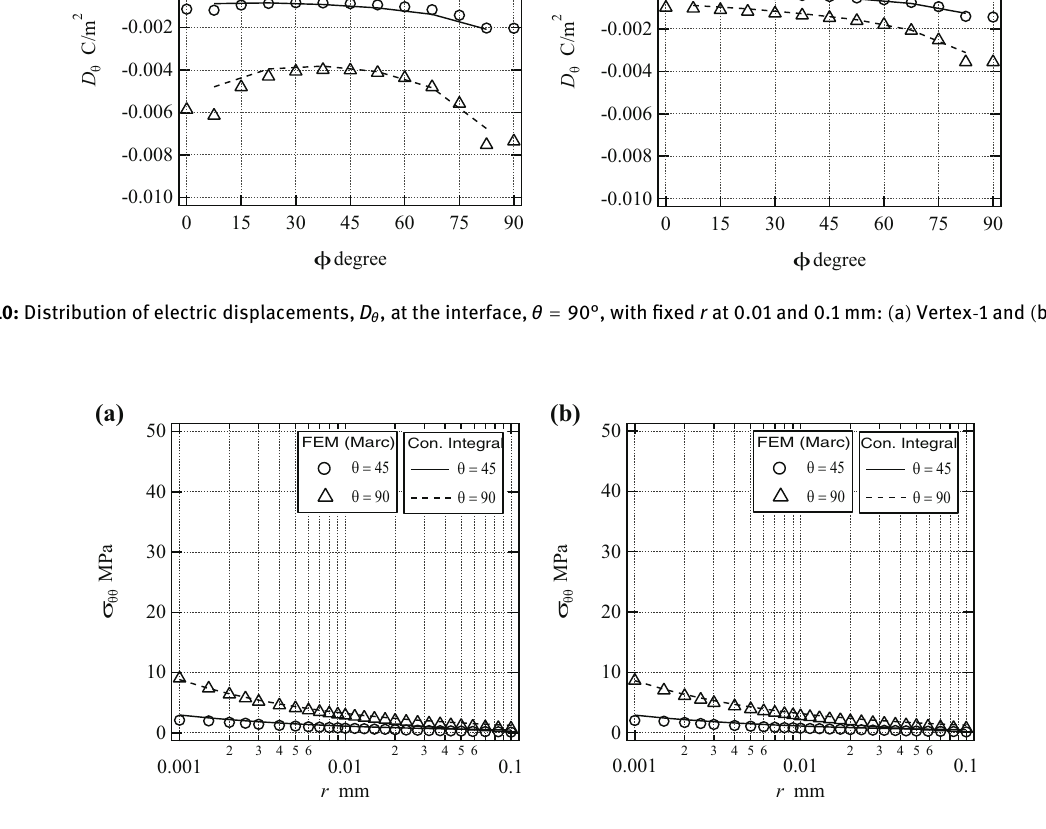
Figure 11: Distribution of normal stresses, σ θθ , at ϕ = 90° and θ = 45° and 90° with respect to r on the singular line ( front - line at d = 3 mm ) : ( a ) Model - 1 and ( b ) Model -